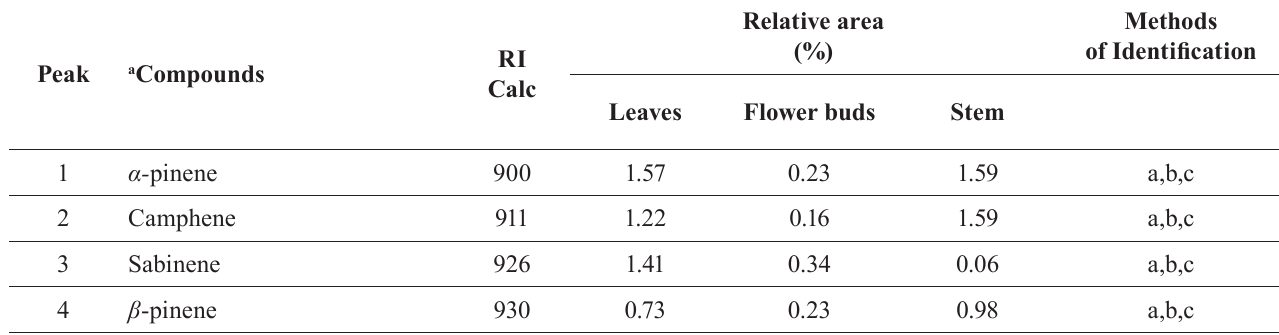
TABLE I - C hemical composition of Tetradenia riparia leaves, flower buds and stem essential oil